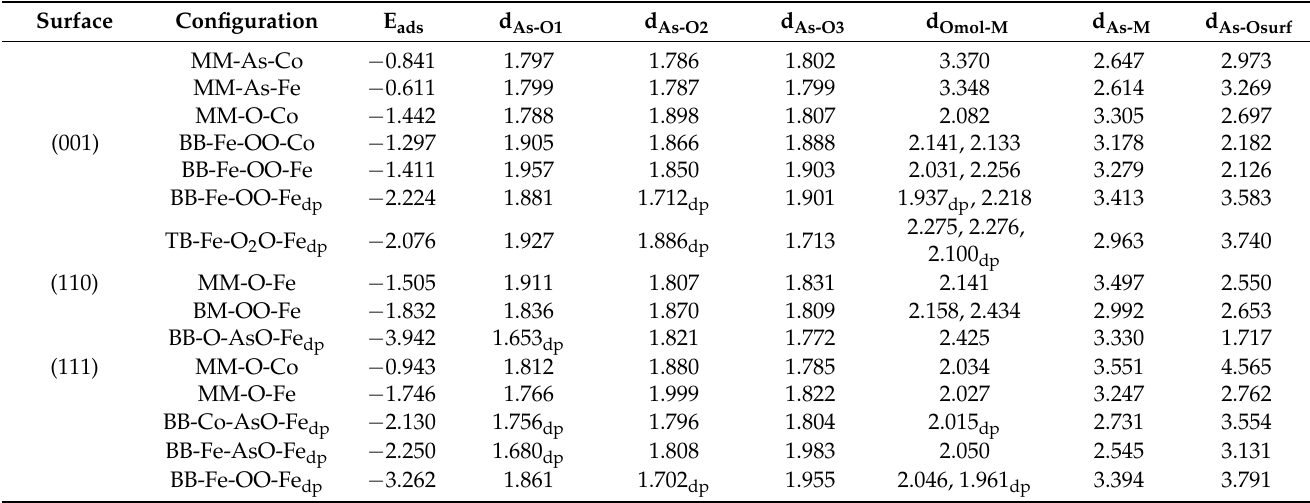
Table 1. Calculated adsorption energies (eV) and bond lengths (Å) within the most stable unique adsorption geometries of H 3 AsO 3 on dry Fe 2 CoO 4 (001), (110), and (111) surfaces. O mol = oxygen of adsorbing molecule, and O surf = nearest surface oxygen (dp = deprotonated). MM = monodentate mononuclear; BB = bidentate